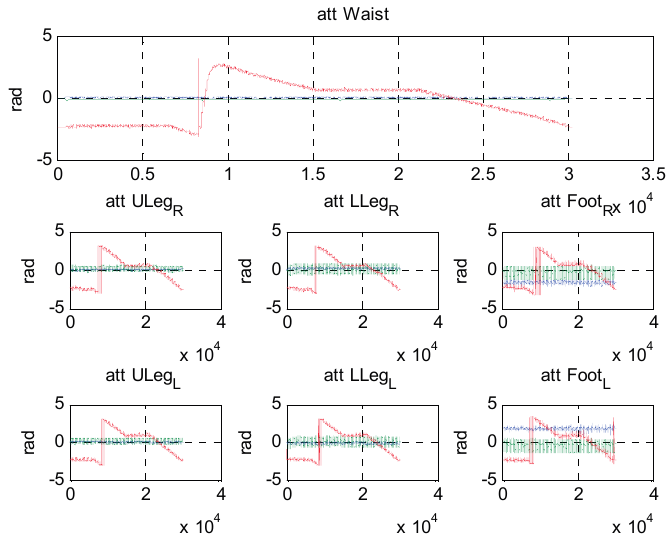
Figure 20. Results of estimated attitude of all segments during long distance trajectory (blue: roll, green: pitch, red: yaw). Attitude of right leg segments located at second row, and left leg segments located at third